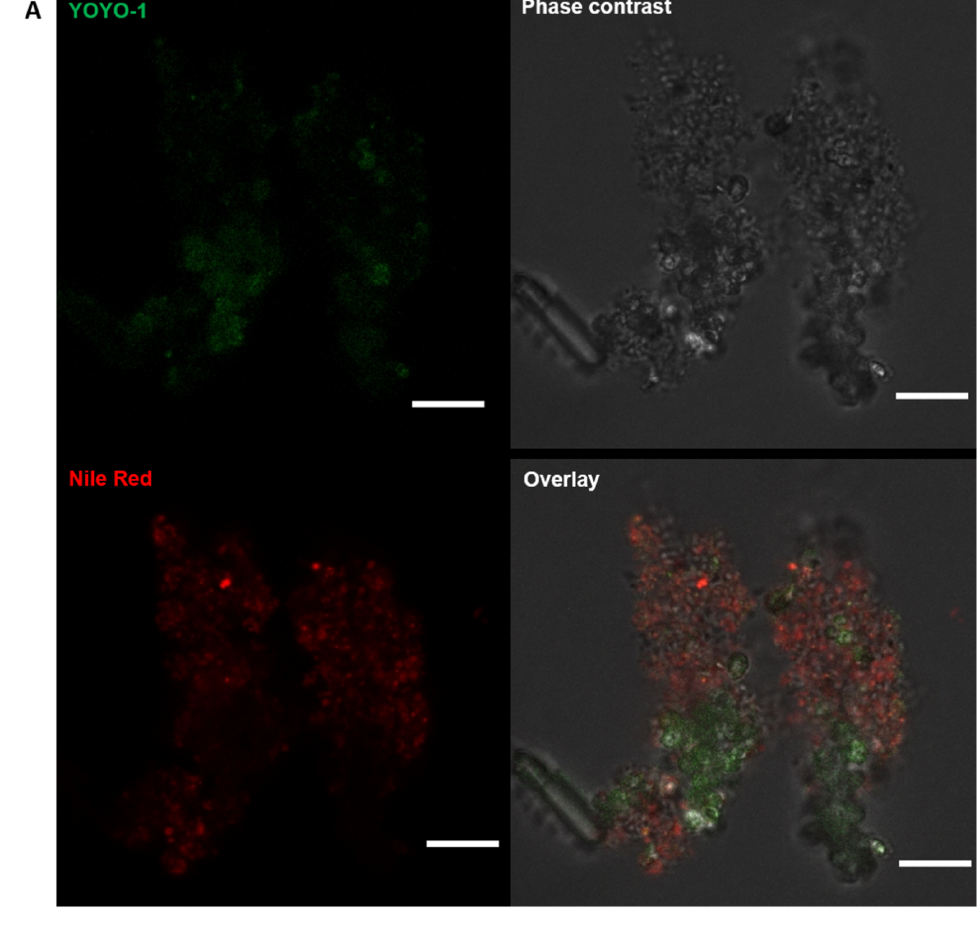
Figure 10. CLSM images acquired using Leica SP8 at 63× of P. atlantica EPS MGP model stained for eDNA with YOYO-1 (green); Nile red (red) as counter stain for bacterial cell walls to localise the presence of eDNA. Scale bar = 5 µm ( A ). Quanti fi cation of the fl uorescence intensity of each fl uoro- phore revealed high mean value of YOYO-1, indicating the presence of eDNA. The control is un- stained particles. The graphs present the mean ± SD of 15 CLSM micrographs. Error bars represent the standard deviation of the data set ( n = 3), p < 0.05 ( B ).